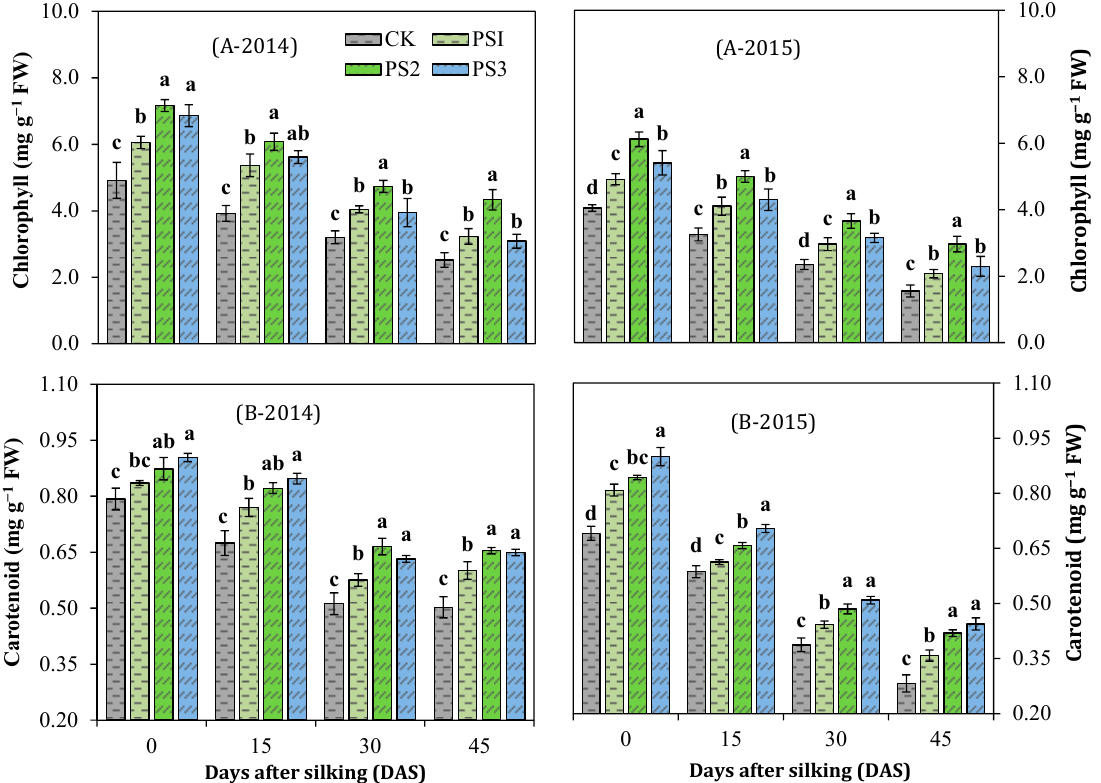
Figure 3. Effects of paclobutrazol treatments on ( A ) chlorophyll and ( B ) carotenoid contents in maize leaves during 2014 and 2015. Data are presented as mean ± SD of three measurements. Different small letters (a,b,c,d,ab,bc) on the bars indicate significant differences at P < 0.05 (LSD test). The abbreviations of treatment names are the same as those described in Figure 2.